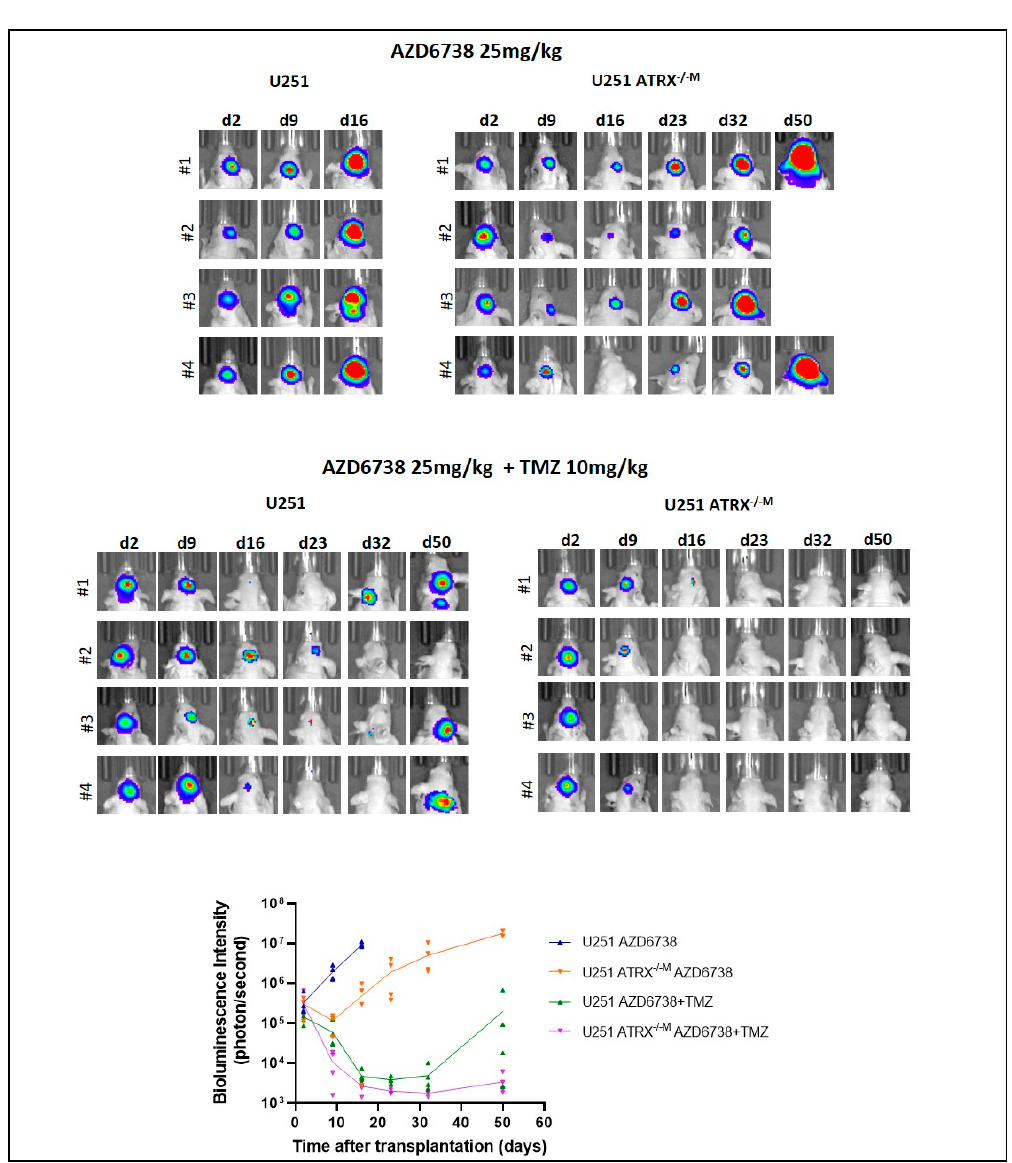
Figure 8. ATR inhibition transiently impairs growth in the NF1 glioma cell line U251 with ATRX loss. Orthotopic xenografts using the glioma cell line U251 demonstrate transient growth inhibition after treatment with the ATR inhibitor, AZD6738. Growth inhibition is more persistent when combined with temozolomide.